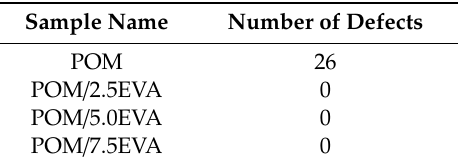
Table 9. The number of defects detected for analyzed samples.